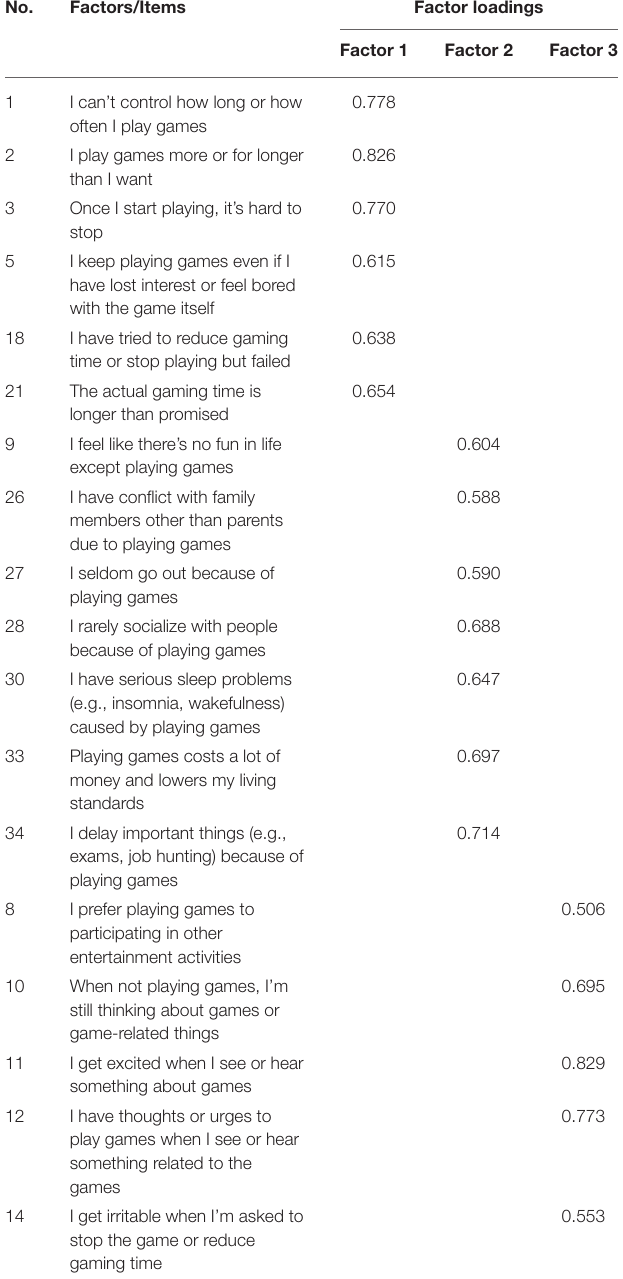
TABLE 3 | Item analysis results of the Gaming Hazard Assessment Scale (sample 1, n = 572). Sequence no.